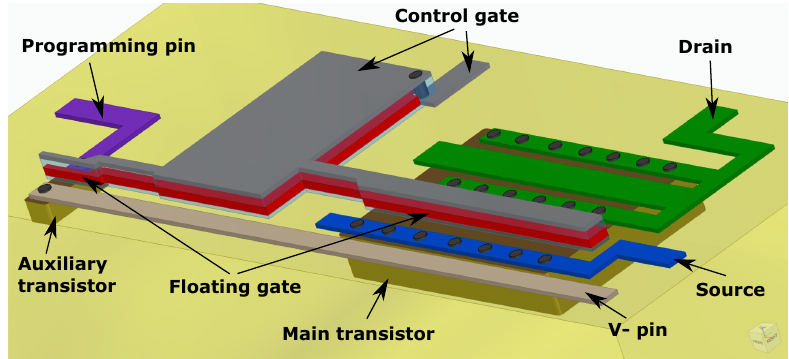
Figure 5. A simplified 3D representation of the EPAD structure.